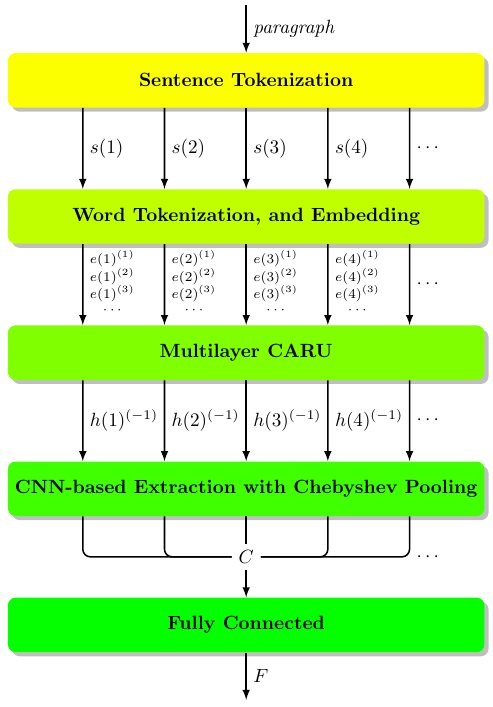
Figure 1. Diagram of our proposed model. Multilayer CARU is able to extract information and discriminative feature embedding to perform sentiment analysis for NLP, and the Chebyshev pooling projects the feature into a type of probability distribution in order to extract more effective features for better decision